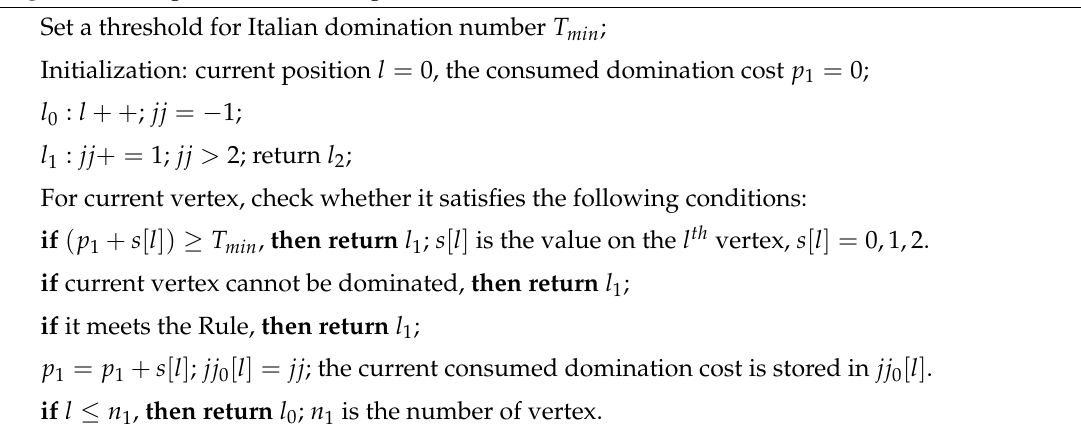
Algorithm 1 Algorithm for finding IDFs of C n (cid:50) C m